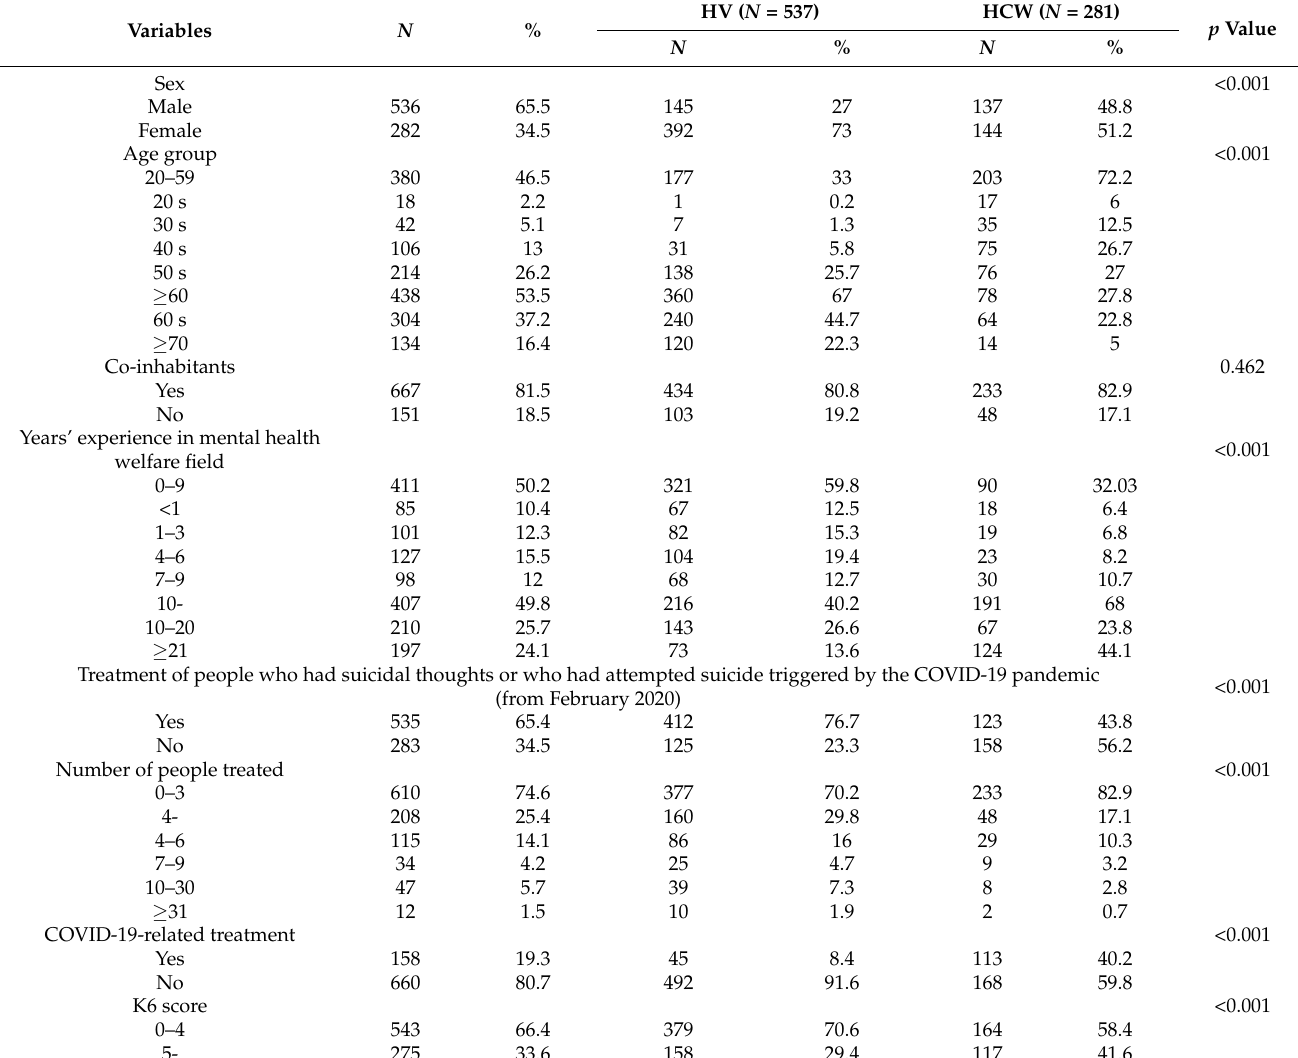
Table 1. Characteristics of SPSs ( n =